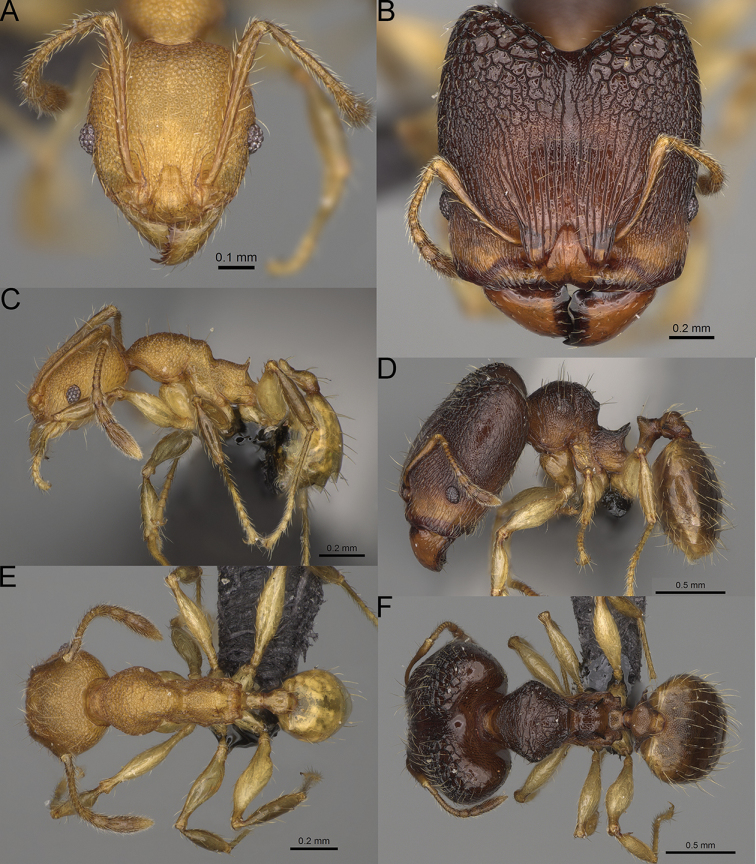
Pheidole
mavesatra sp. nov., full-face view (A), profile (C), and dorsal view (E) of paratype minor worker (CASENT0923177) and full-face view (B), profile (D), and dorsal view (F) of holotype major worker (CASENT0134807).